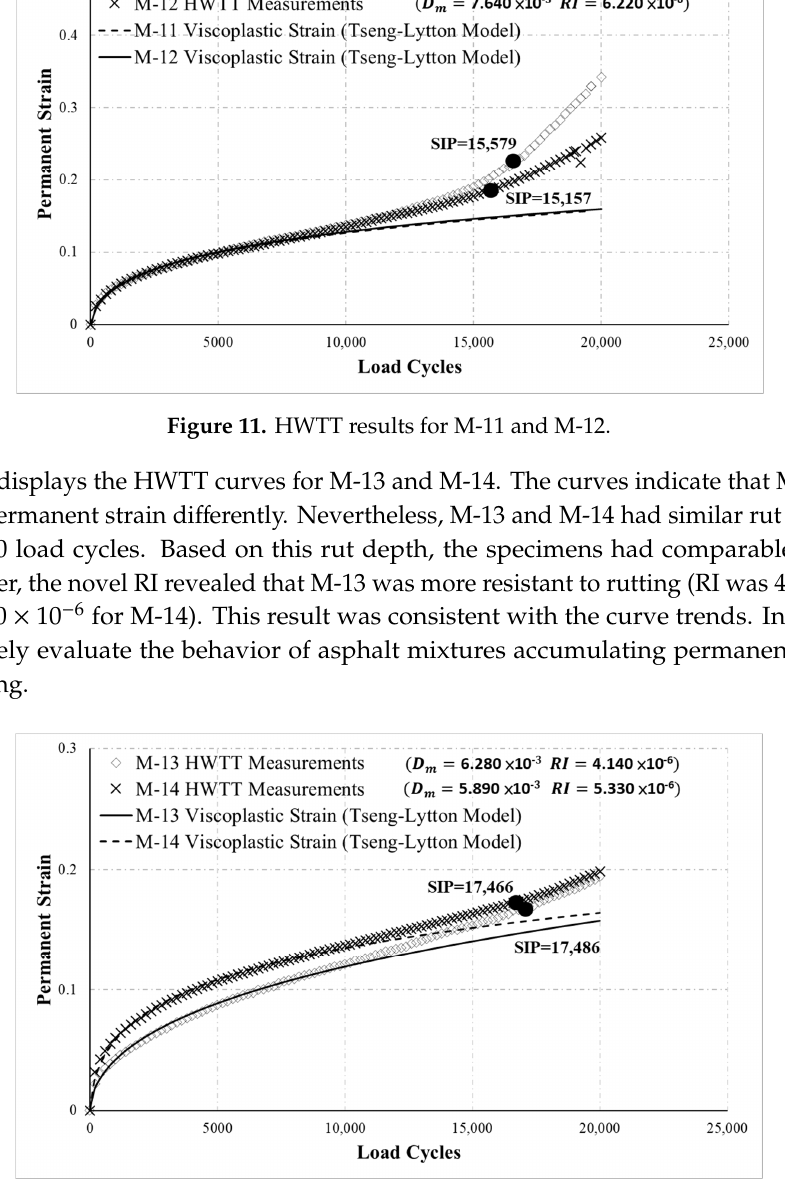
Figure 12. HWTT results for M-13 and M-14.